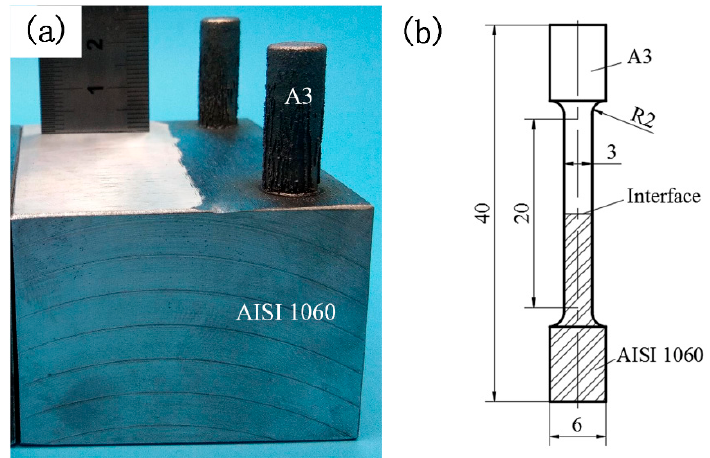
Figure 12. ( a ) Representative specimens after the 410L + 12.5% Fe–Cr–B–Si–Mo was deposited onto the AISI 1060 steel substrate; ( b ) dimensions of the tensile samples of repair.